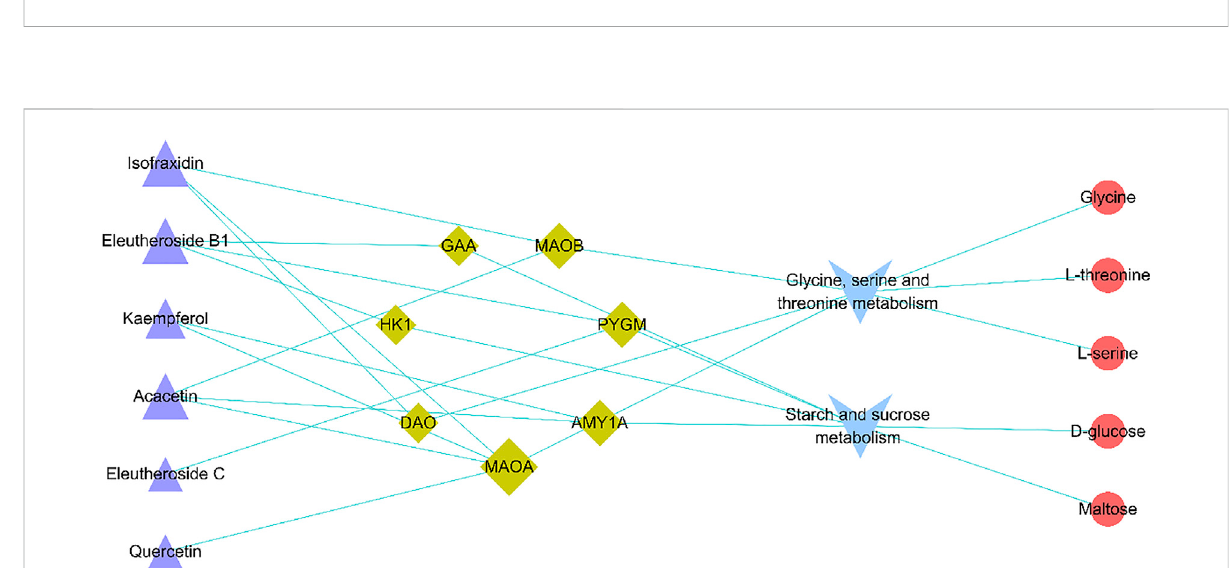
FIGURE 7 Active compound – overlapping target-metabolic pathway potential biomarker interaction network. Purple triangle: active compounds; green diamond: targets; blue V: metabolic pathways; red circle: potential biomarkers. The bigger nodes represent greater degrees.